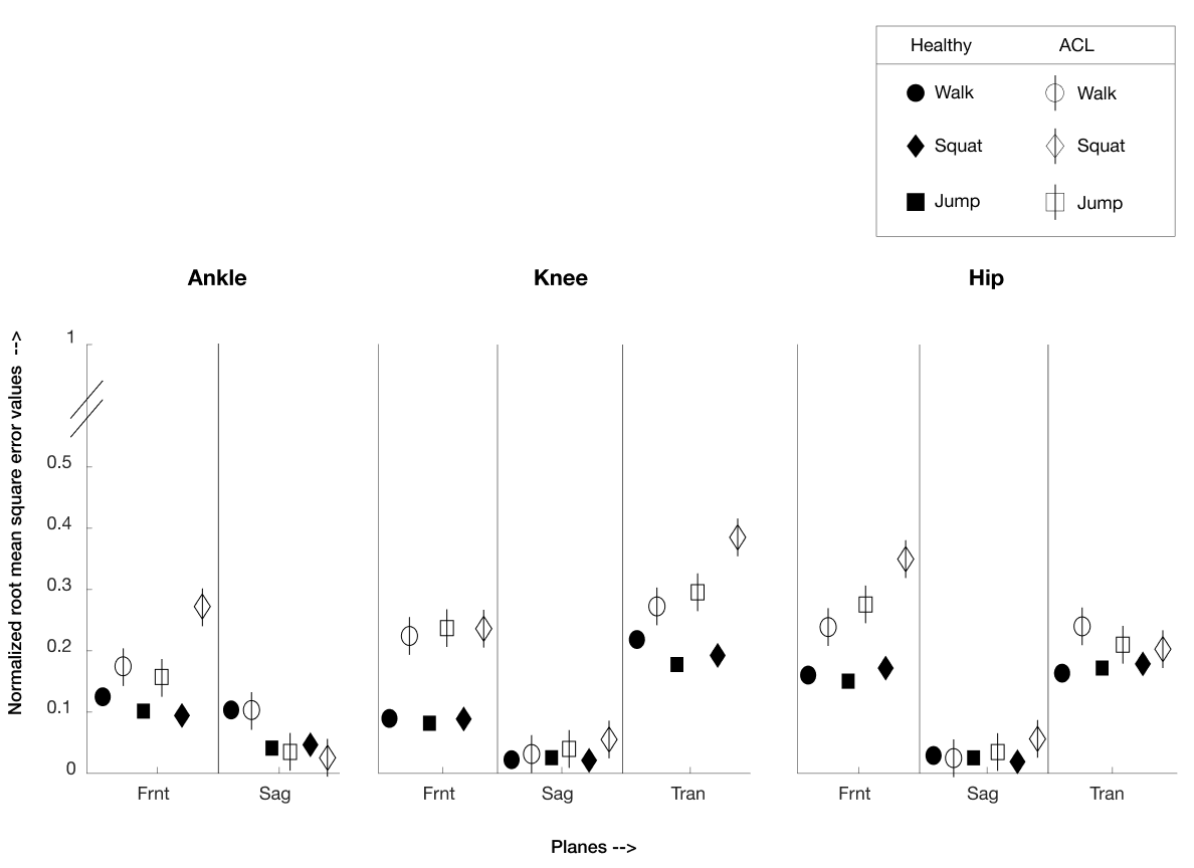
Figure 9. Normalized root mean square error values between MVN Analyze and MoJoXlab for healthy participants (black) and ACL reconstruction participants (white), presented in a graphical format for visualization and overall comparison purposes. Values close to 0 indicate a very low error (circle—values for the walk task, square—values for jump task, and diamond—values for squat task; planes: Frnt—Frontal, Sag—Sagittal, and